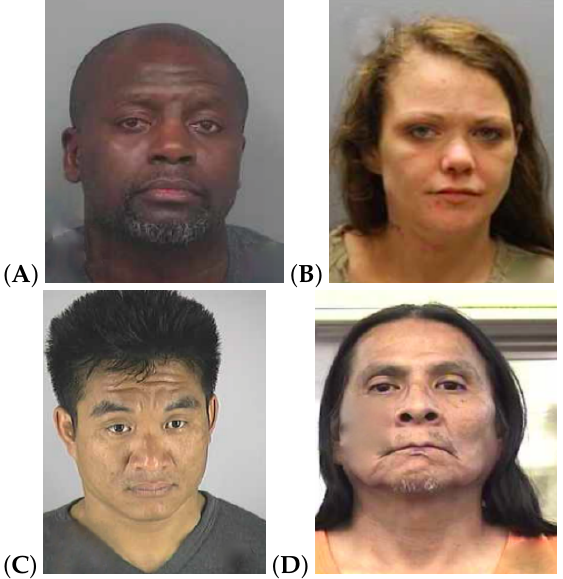
Figure A2. Pictures of characters in the story shown to the study participants: ( A ) is the purse- snatcher, ( B ) is the victim and ( C ) and ( D ) are the